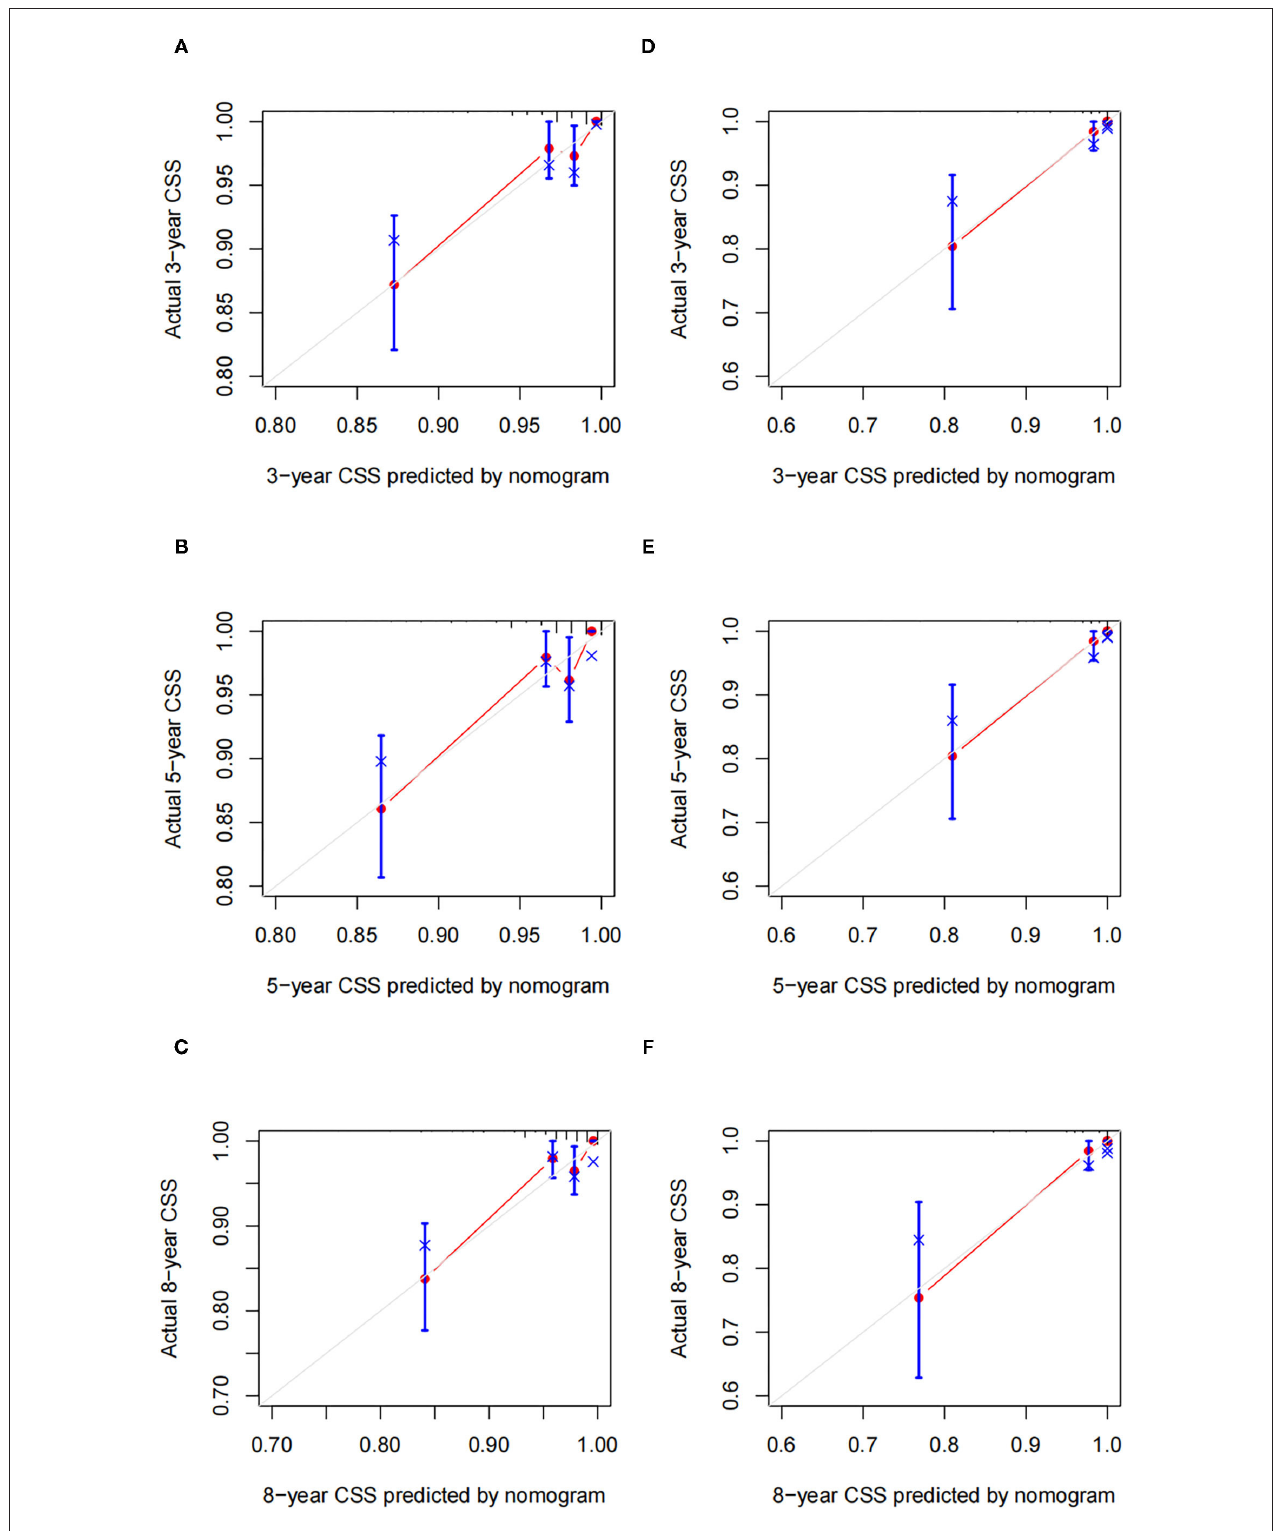
FIGURE 3 | Calibration plots of a nomogram for 3-, 5-, and 8-year CSS in training cohort (A–C) and validation cohort (D–F) .